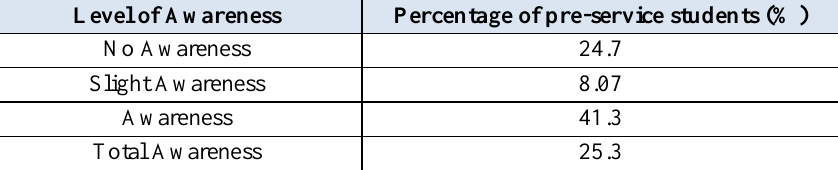
Table 2. Showing the awareness about Helpful Technology Level of